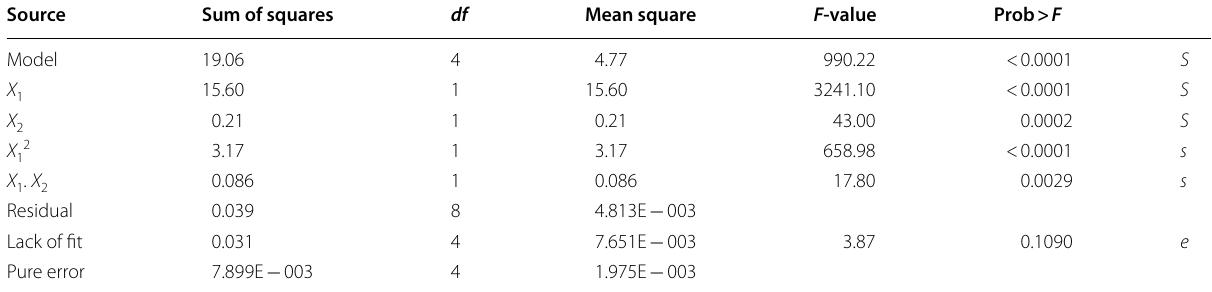
Table 10 ANOVA results for the CCD (Model